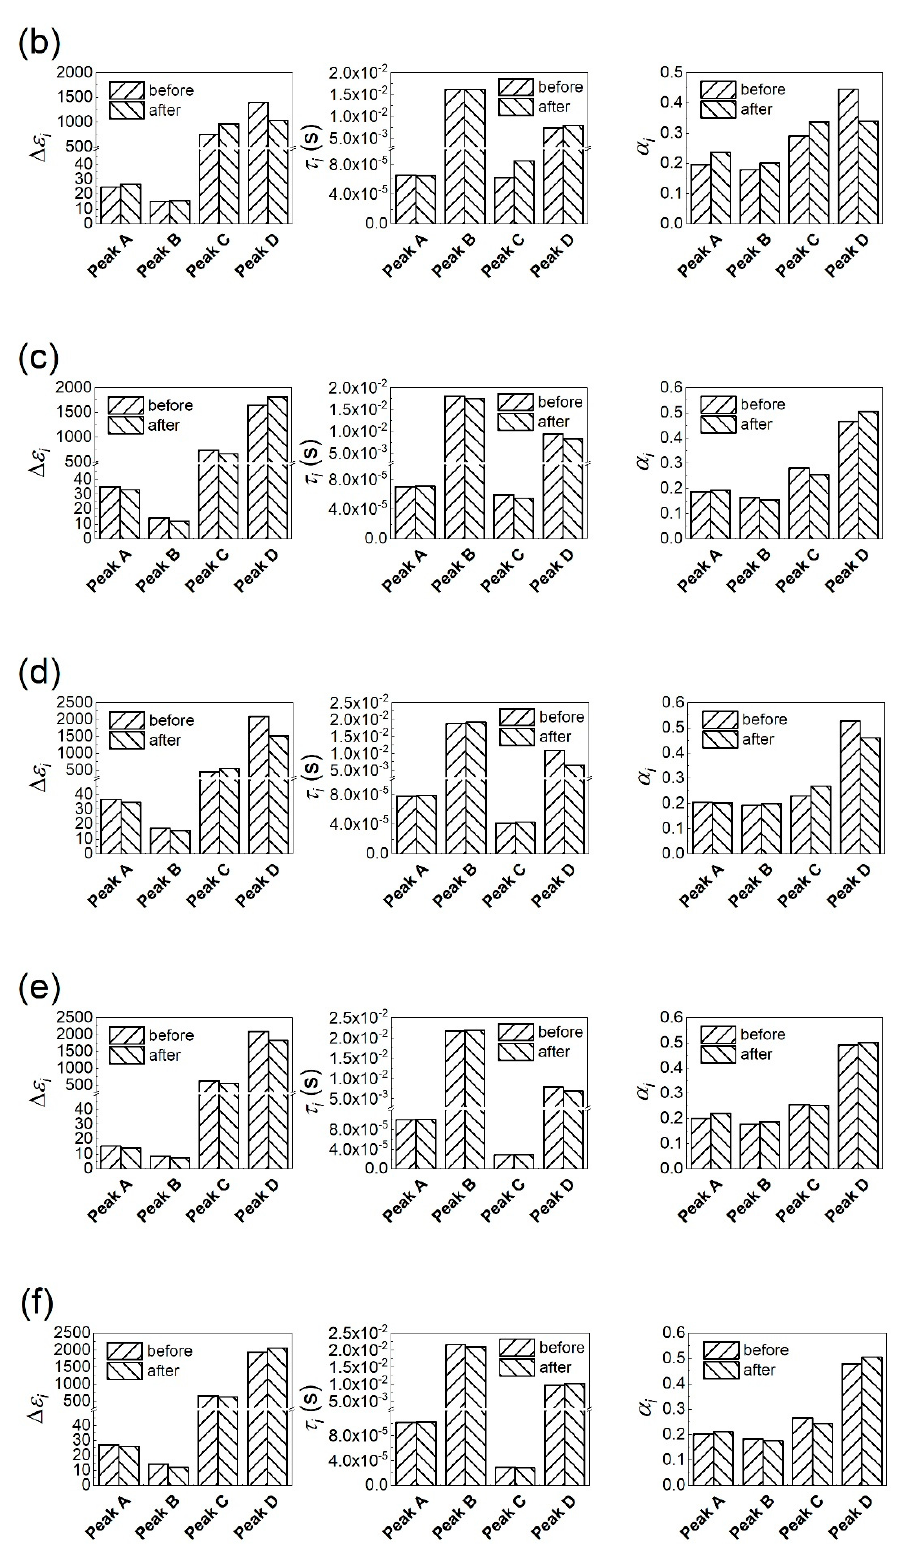
Figure 5. Parameters of all loss peaks before and after DC aging ( a – f ) S1–S6. DC conductivities ( σ dc ) were obtained from σ ’ spectra at 0.1 Hz, which was also calculated via dielectric responses at higher temperatures. σ dc of S1–S6 at 200 ◦ C before and after DC aging are shown in Figure 6a. After DC aging, σ dc increases for every sample. As σ dc was obtained from frequency-domain conductivity at the lowest